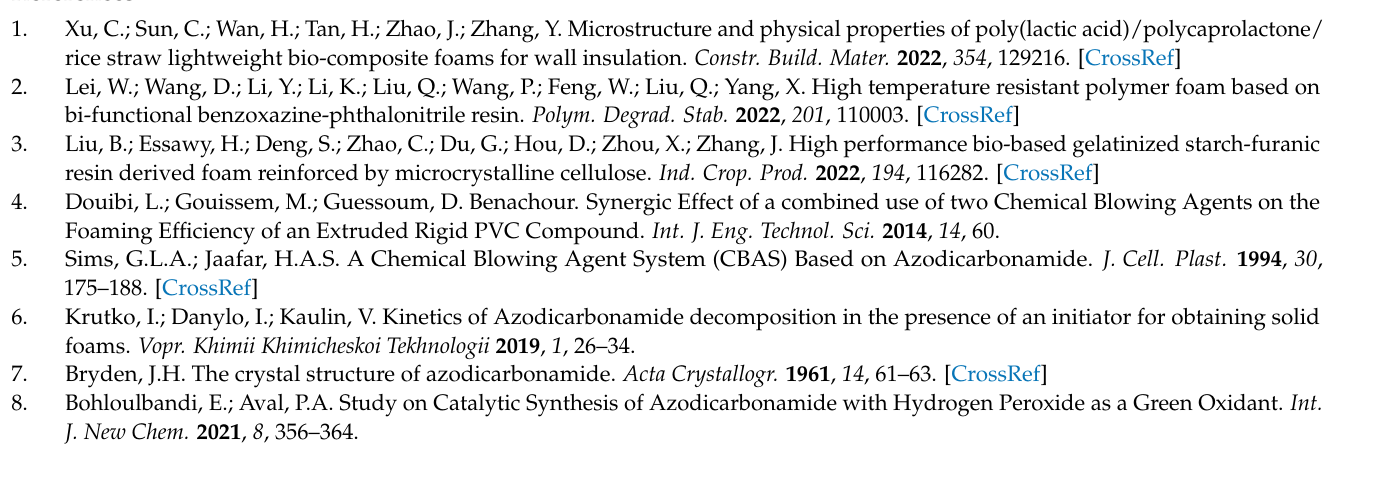
b. FTIR spectrum of Ni(II) complex. c. FTIR spectrum of Cu(II) complex. d. FTIR spectrum of Zn(II) complex, Figure S2: a. Mass spectra of Azodicarbonamide ligand [40]. b. Mass spectra of Ni(II) complex. c. Mass spectra of Cu(II) complex. d. Mass spectra of Zn(II) complex, Scheme S1: Decompo- sition reaction for azodicarbonamide, Scheme S2: Fragmentation pattern of azodicarbonamide ligand, Scheme S3: Fragmentation pattern of Ni(II) complex, Scheme S4: Fragmentation pattern of Cu(II) complex, Scheme S5: Fragmentation pattern of Zn(II)